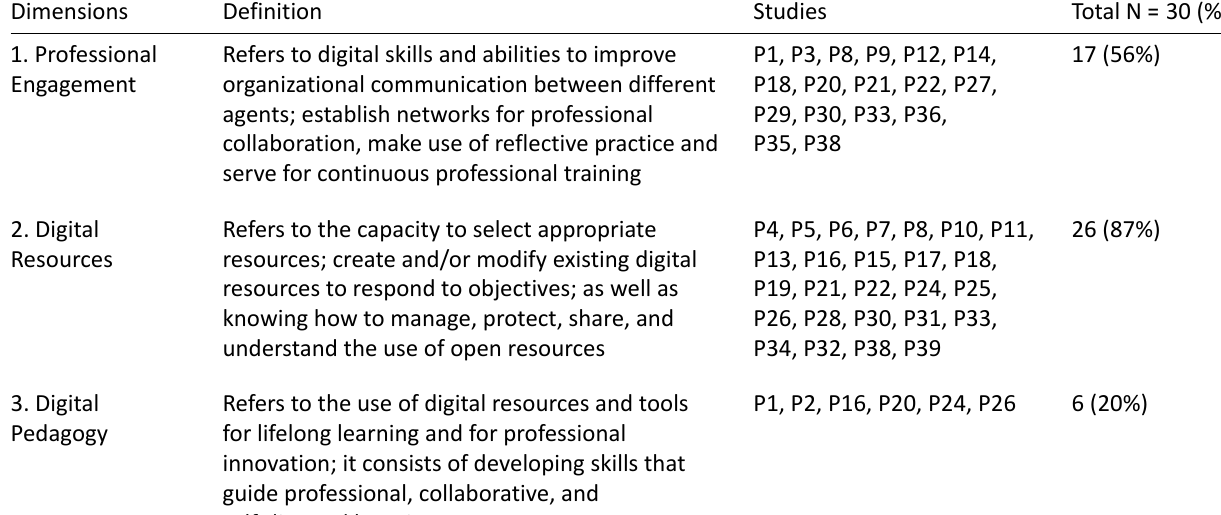
Table 4. Studies and dimensions of digital competence based on digital competence in education. Dimensions